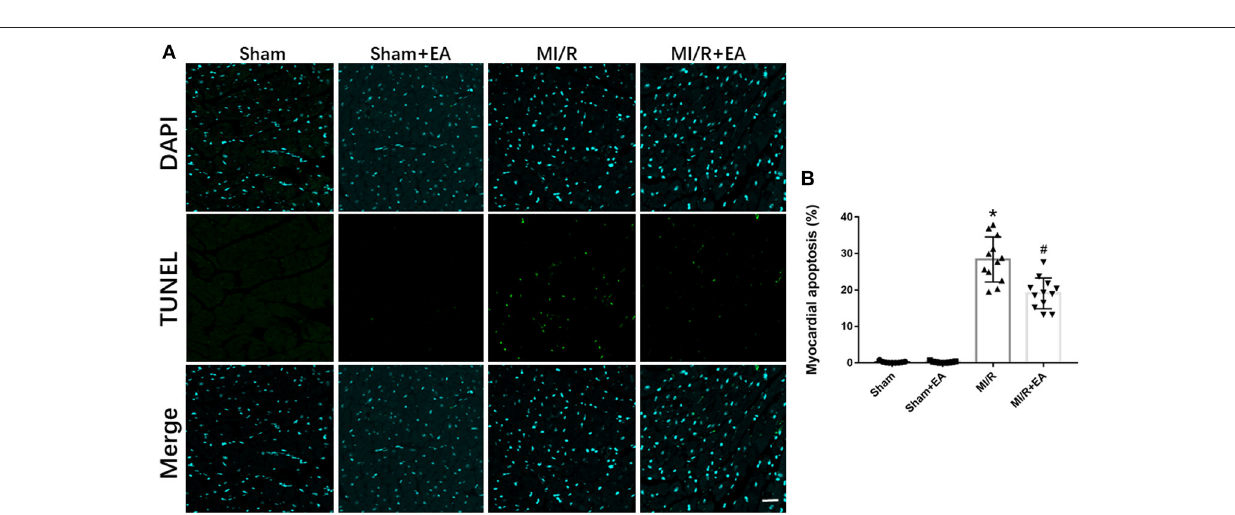
Frontiers in Cardiovascular Medicine |